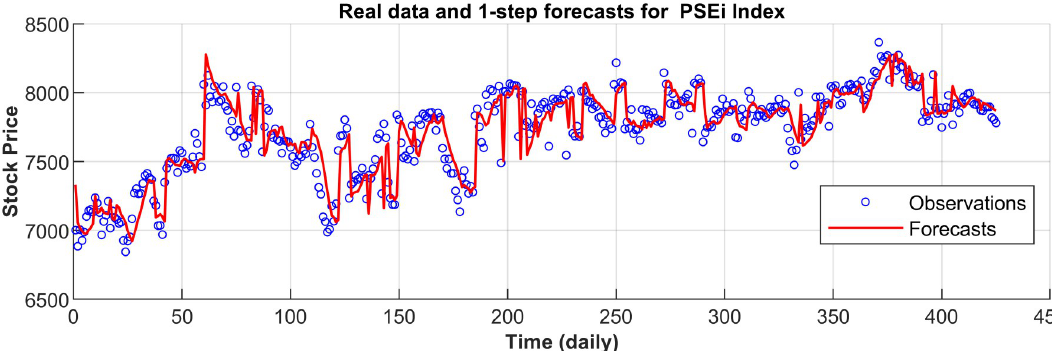
Fig 7. 1-step forecasts of the nPRM and market values for the Philippines PSEi